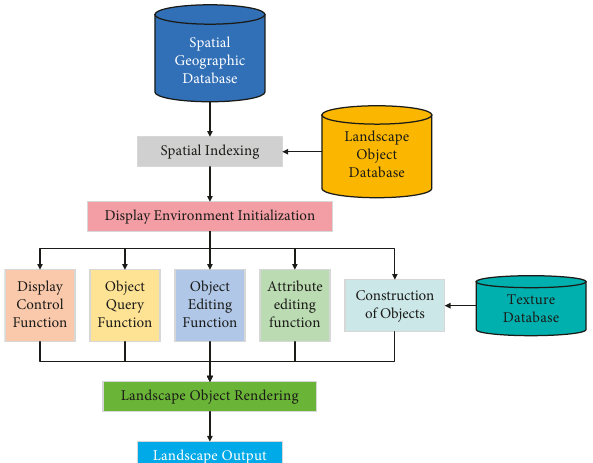
Figure 1: Digital city 3D landscape design